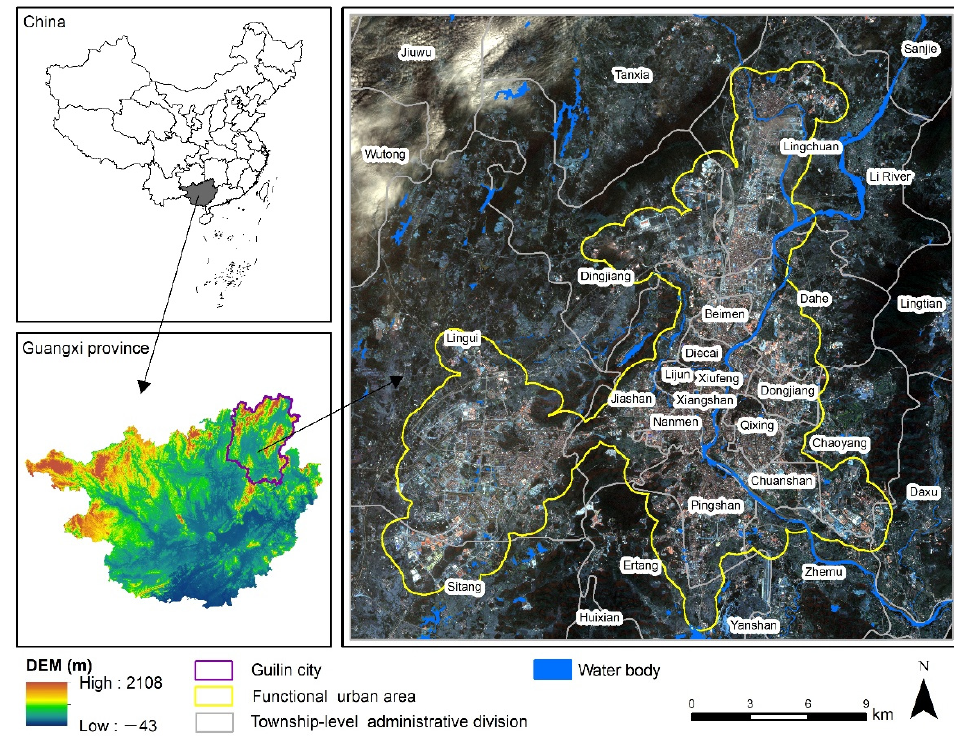
Figure 1. Geographic location of the study area.